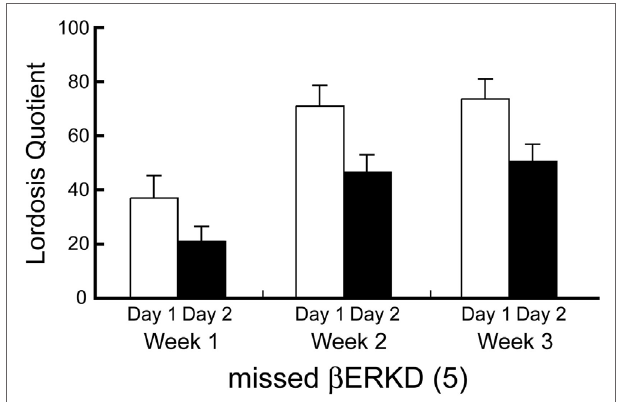
FigUre 7 | Lordosis quotient of missed ER β knockdown ( β ERKD) mice. Data presented as mean ±